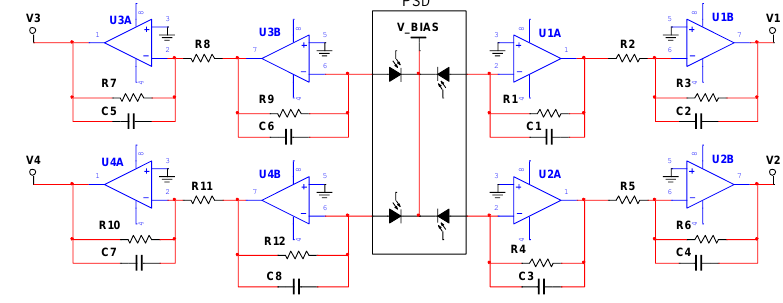
Figure 4. PSD signal conditioning circuit.